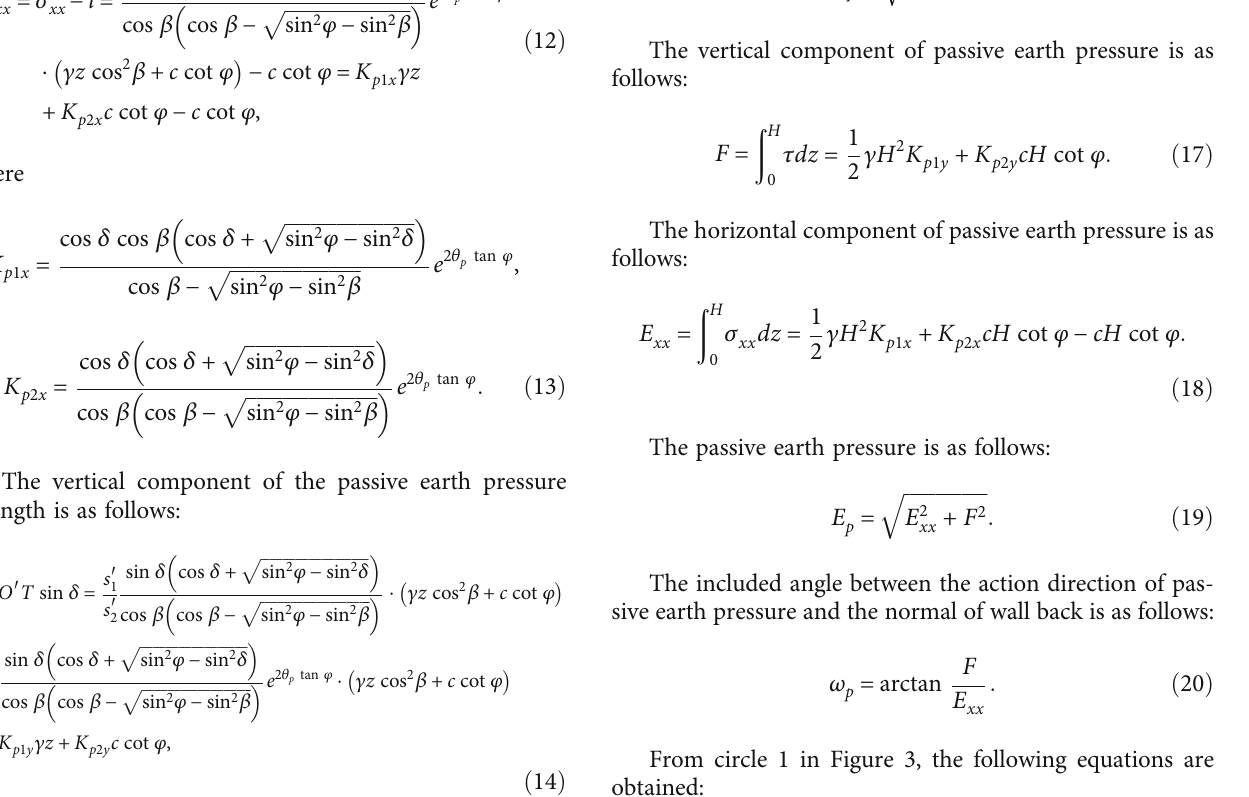
p(cid:5) ffiffiffiffiffiffiffiffiffiffiffiffiffiffiffiffiffiffiffiffiffiffiffiffiffi sin 2 φ − sin 2 δ p(cid:5) ffiffiffiffiffiffiffiffiffiffiffiffiffiffiffiffiffiffiffiffiffiffiffiffiffiffi sin 2 φ − sin 2 β